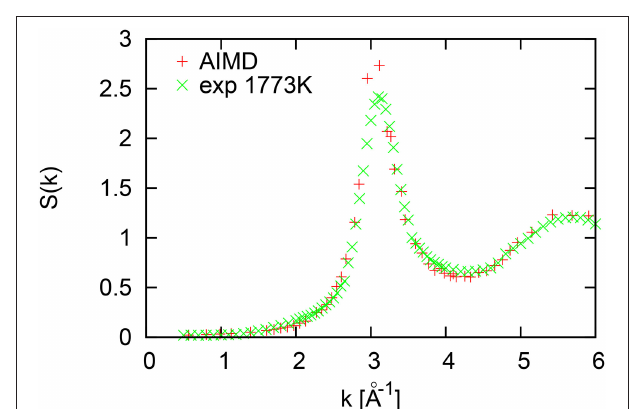
FIGURE 5 | Structure factor of liquid Ni at 1735